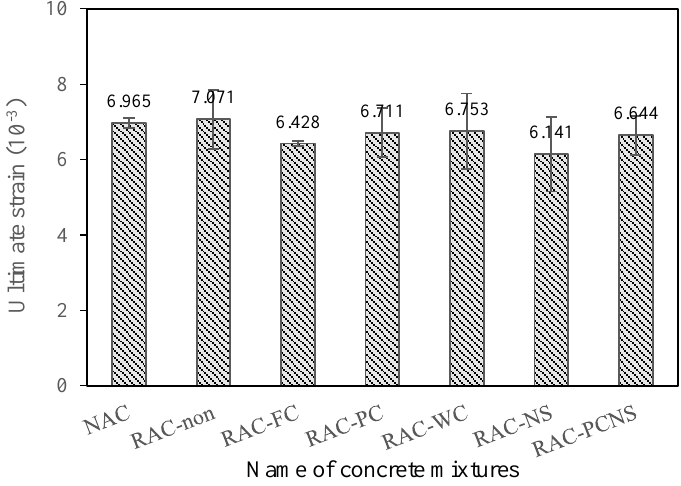
Figure 9. Ultimate strain of hardened concretes.